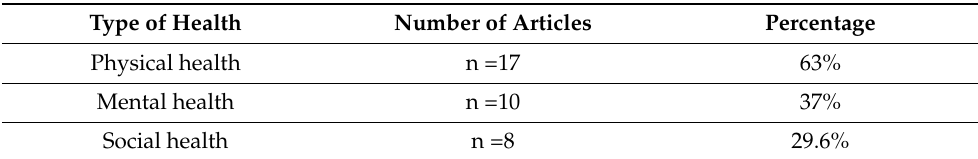
Table 4. Types of health